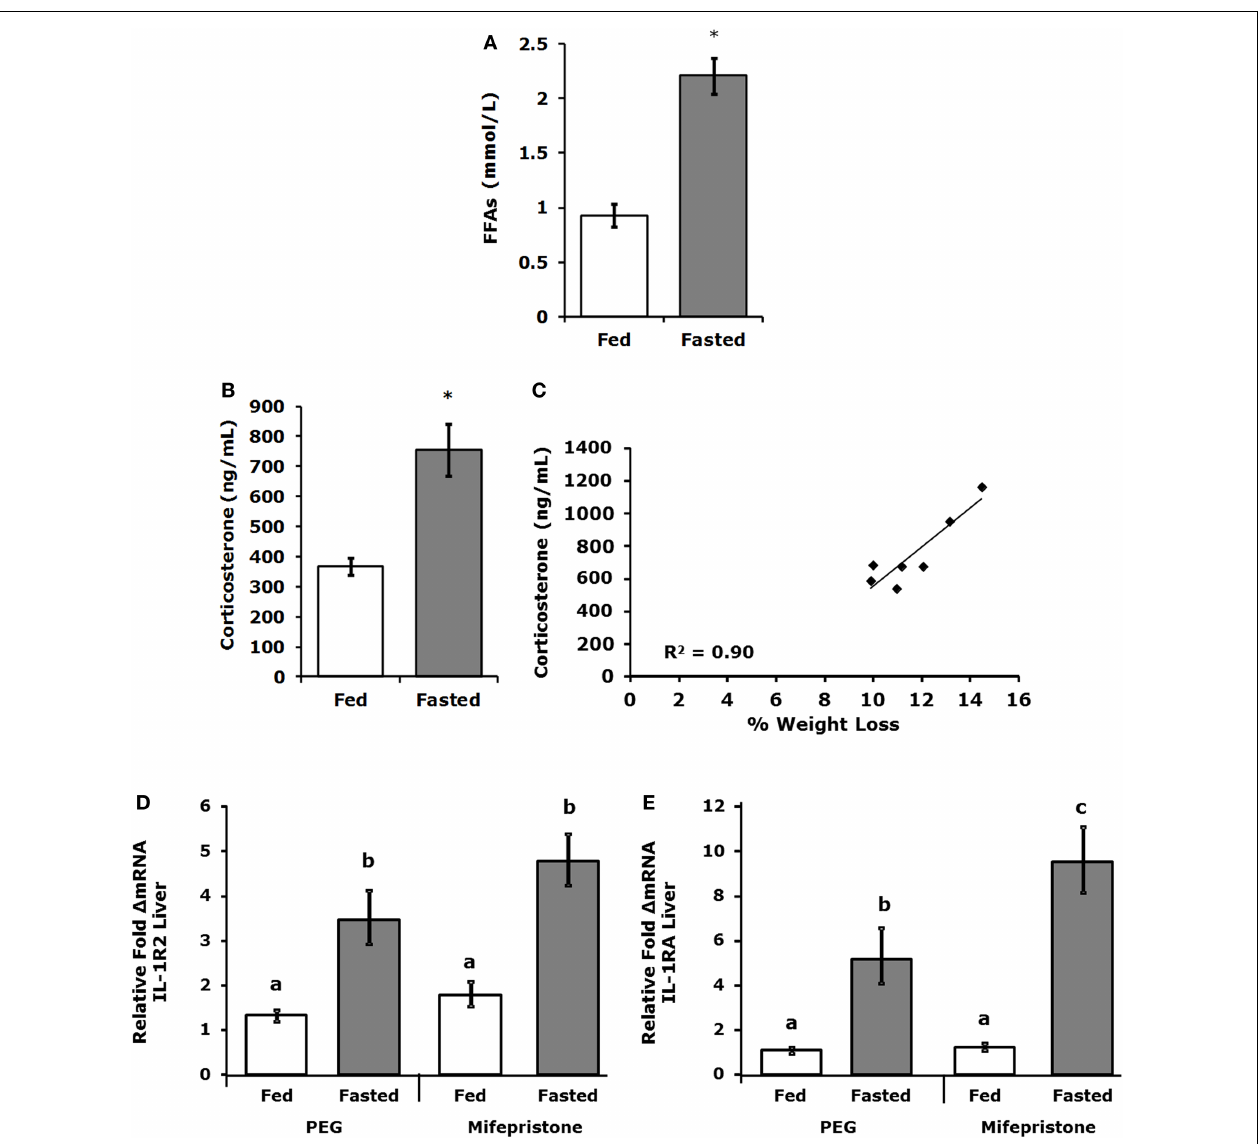
P = 0.005. (D,E) Mice were treated SQ with or without mifepristone then fed or fasted for 24h. Gene expression of IL-1R2 and IL-1RA were measured in the liver. IL-1R2 gene expression was expressed as relative fold change in mRNA, means ( + SEM upper, − SEM lower); n = 4–6. Bars without a common superscript are different (* P < 0.05). IL-1RA gene expression was expressed as relative fold change in mRNA, means ( + SEM upper, − SEM lower); n = 4–6. Bars without a common superscript are different (* P < 0.05).